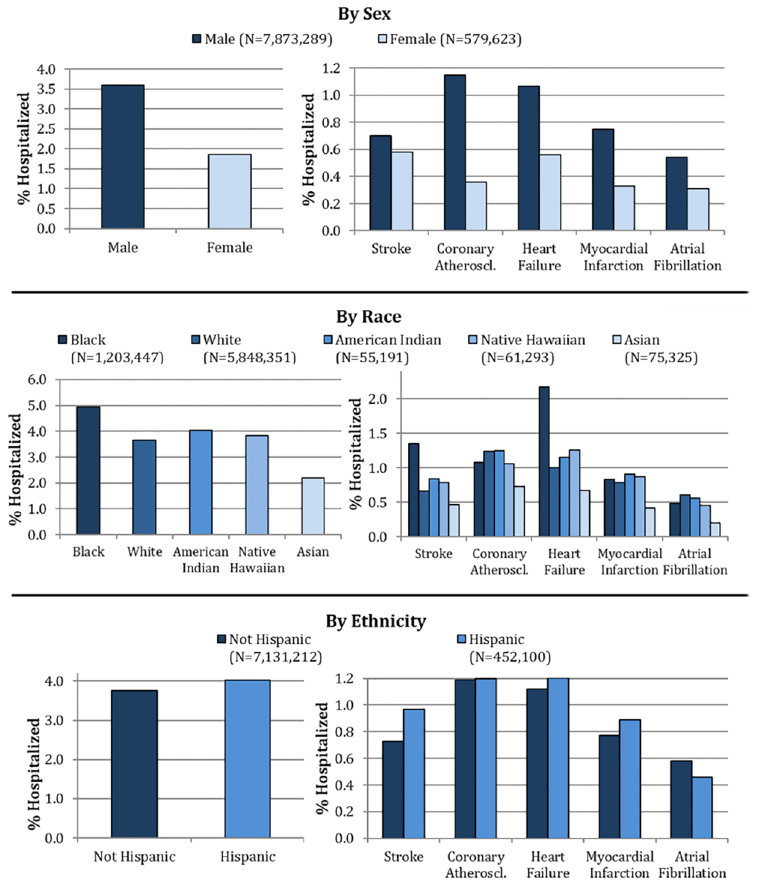
Fig 1. Variation in hospitalization rates by sex, race and ethnicity. Coronary atheroscl.: Coronary atherosclerosis.